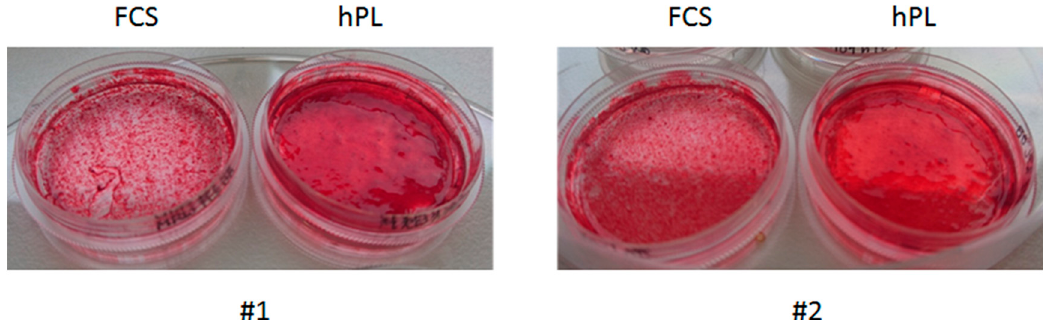
Figure 1. Di ff erent consistency and macroscopic appearance of osteogenically induced JPC monolayers Figure 1. Different consistency and macroscopic appearance of osteogenically induced JPC following FCS and hPL medium supplementation (Alizarin Red staining). Representative images of monolayers following FCS and hPL medium supplementation (Alizarin Red staining). cell monolayers from two donors (#1, #2) cultured in AFM petri dishes (plastic bottom) under both supplementations. Abbreviations: FCS—fetal calf serum, hPL—human platelet